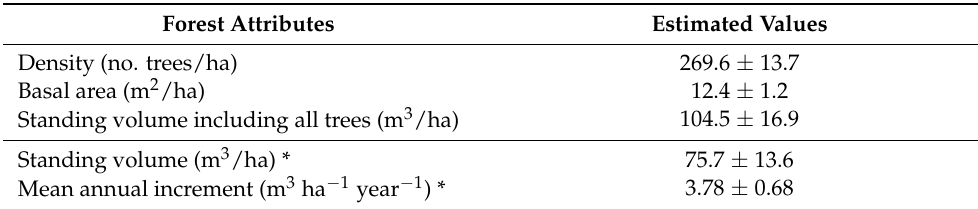
Table 1. Attributes of the 20-year old secondary cloud forest (mean ± SE) in Mexico. The standing volume was calculated including and excluding remnant old trees ( ≥ 55 cm DBH). Forest Attributes Density (no. trees/ha)